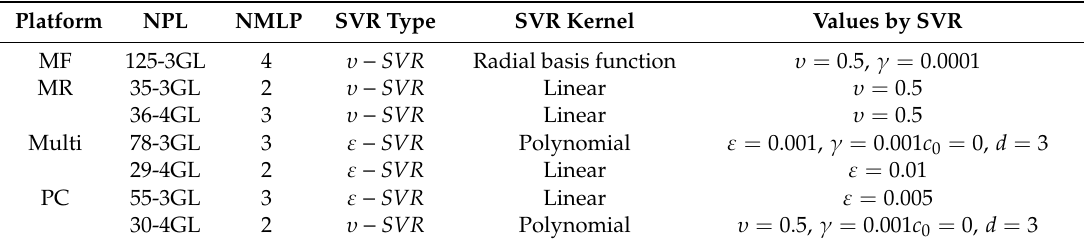
Table 5. Parameter values for MLP and support vector regression (SVR) having the best prediction performance (NMLP: number of neurons in MLP hidden